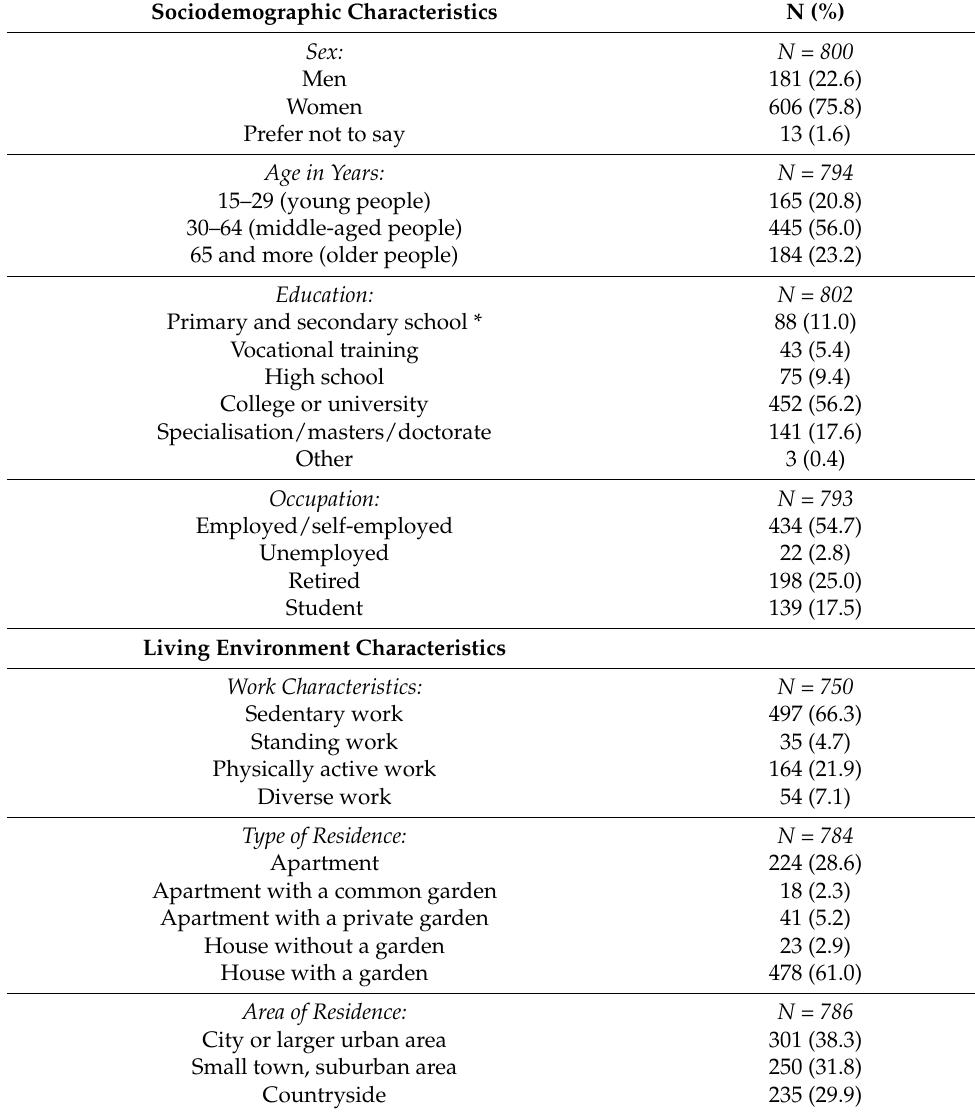
Table 1. Characteristics of the Study Sample (N = 1161, of which missing responses vary among questions and are not included in the